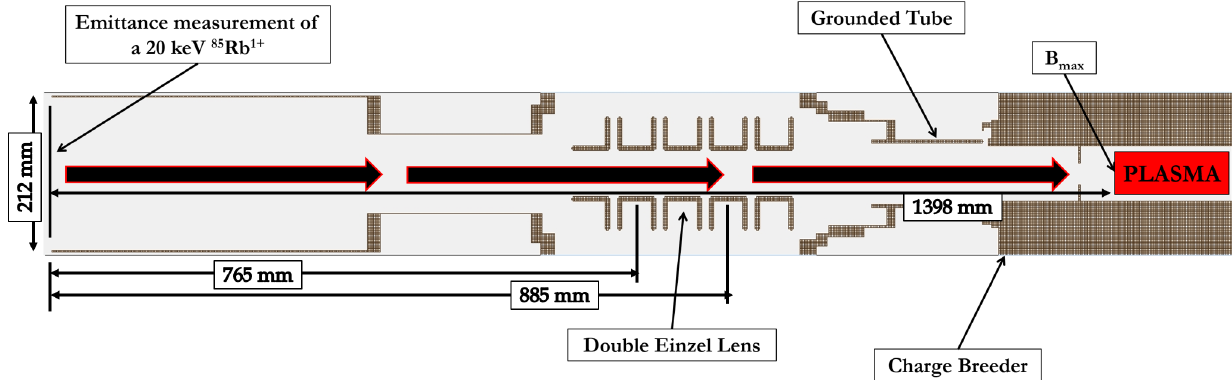
FIG. 1. Geometry used to simulate the injection of a 85 Rb 1 þ into the PHOENIX ECR-CB with the tracking code SIMION . Particles start at the characterization point (on the left in the figure), then, spatial and velocity distribution are obtained at the position corresponding to the maximum of the magnetic field at injection (B ). Cylindrical symmetry must max